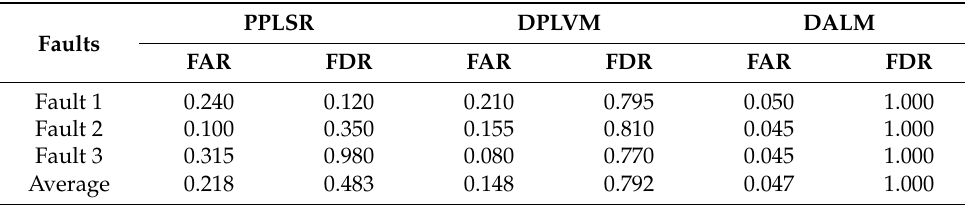
Table 5. FAR and FDR of the three methods under different fault